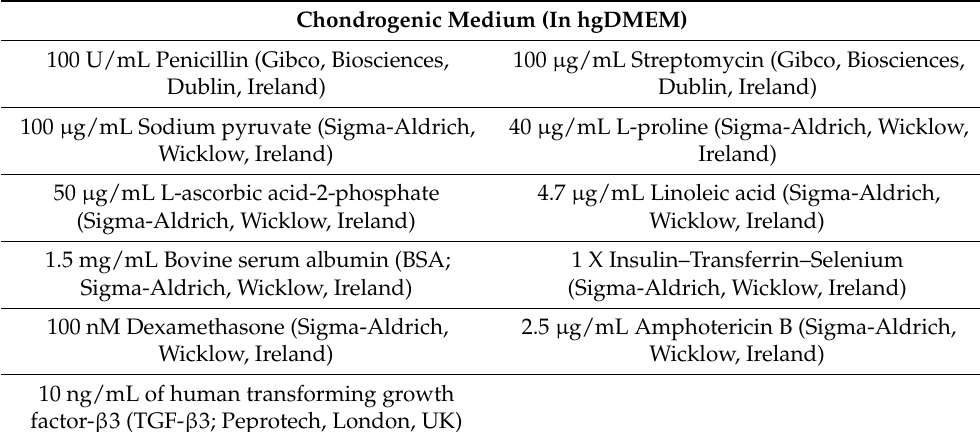
Table 2. Composition of the chondrogenic